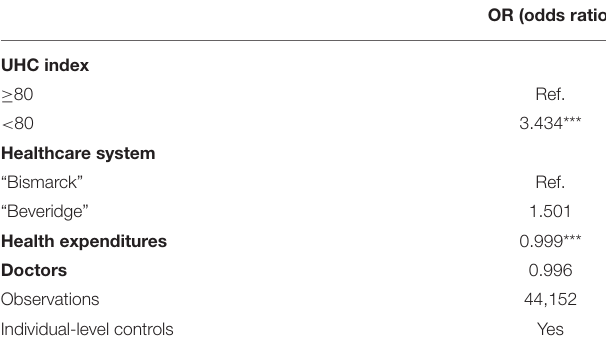
TABLE 5 | Country context effects on the use of remote medical consultations among older